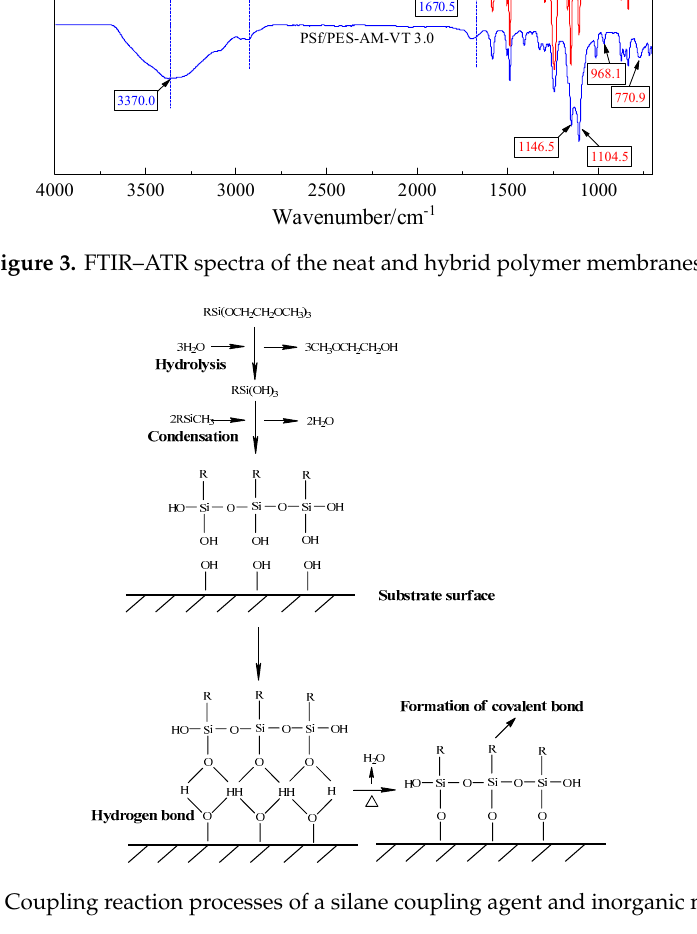
Figure 4. Coupling reaction processes of a silane coupling agent and inorganic materials.